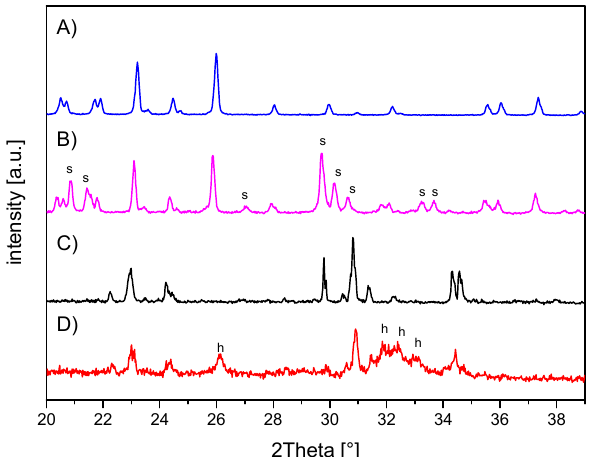
Figure 5. X-ray diffraction patterns of the in-house-prepared cements before and after setting at 37 °C for 24 h. ( A ) Magnesium phosphate cement raw powder; all peaks correspond to farringtonite Mg 3 (PO 4 ) 2 (PDF-No. 33-0876). ( B ) Magnesium phosphate cement after setting with additional struvite (s) phase (PDF-No. 03-0240). ( C ) α -tricalcium phosphate cement raw powder; all peaks correspond to α -TCP (PDF-No. 09-0348). ( D ) Dual setting α -TCP/HEMA cement after setting with additional hydroxyapatite (h) phase (PDF-No. 09-0432).